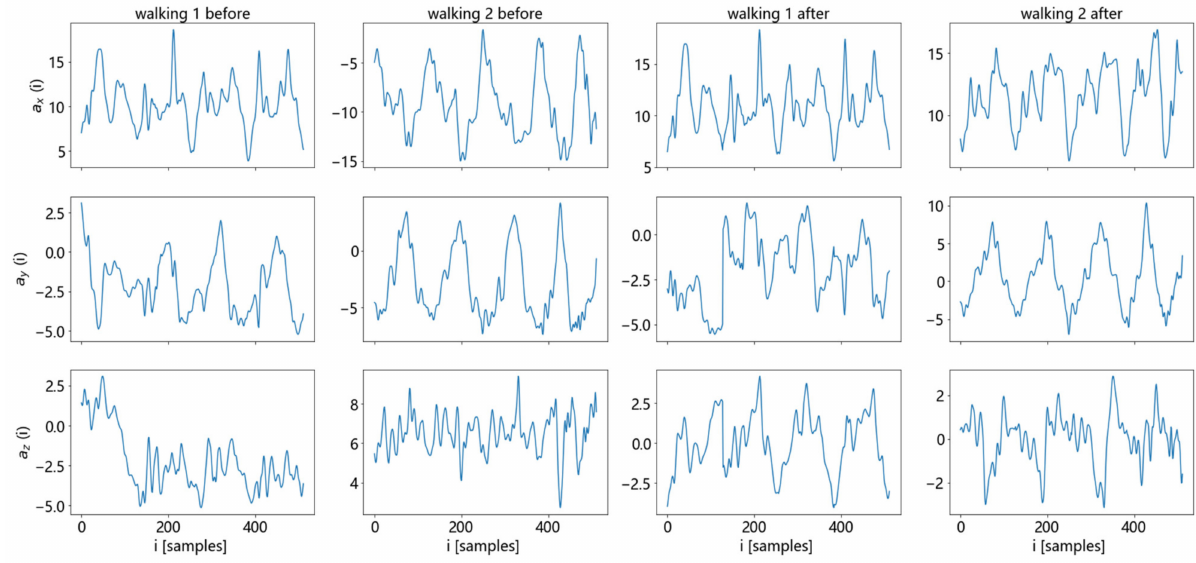
Figure 3. Comparison of accelerations before and after orientation elimination. All the data are collected from one person. For the three subgraphs in each column, the horizontal axis represents time, and the vertical axis represents the projection of acceleration in x, y and z directions. The data in the first and the second column are collected in two different positions respectively, while the data in the last two columns are collected after orientation